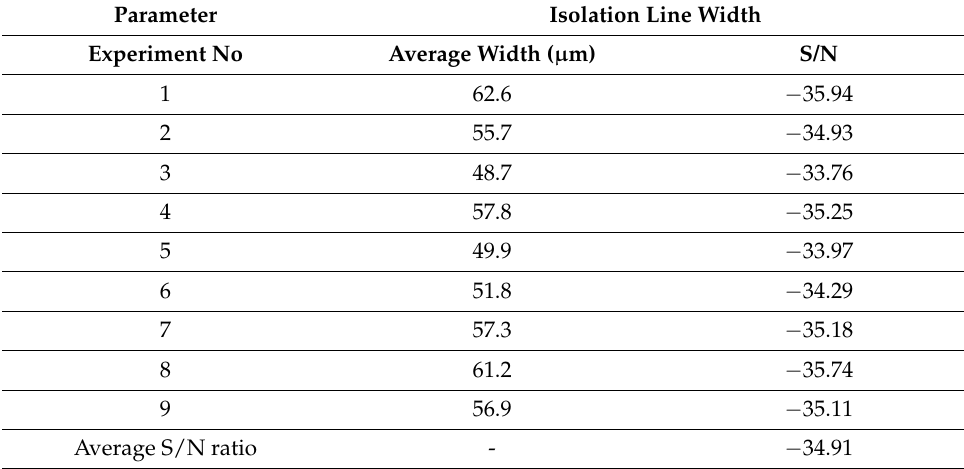
Table 4. The isolation line width with calculated S/N